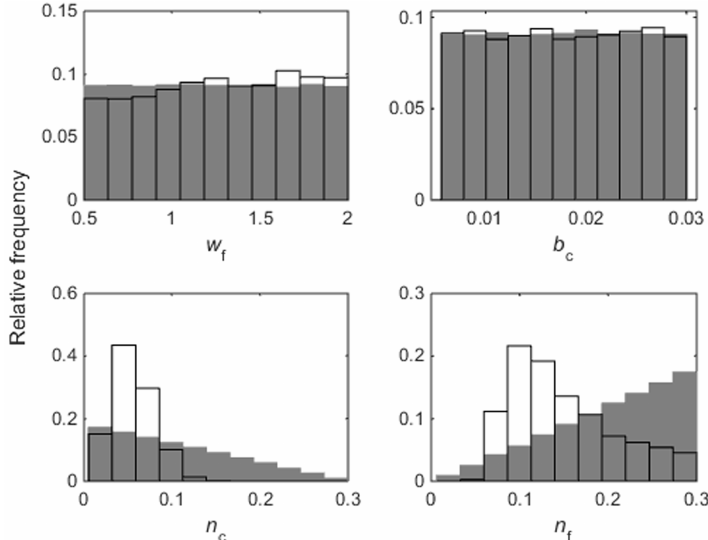
Figure 8. Prior and posterior relative frequency distribution (grey and black outlined bars respectively) of the LISFLOOD-FP parameters (width factor, slope for the downstream boundary condition, channel roughness coefficient, and floodplain roughness coefficient: w f , b c , n c , and n f respectively).